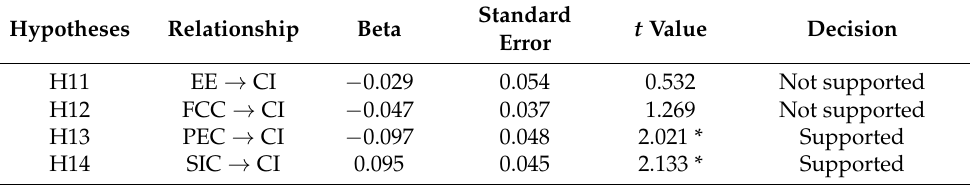
Table 7. Moderating